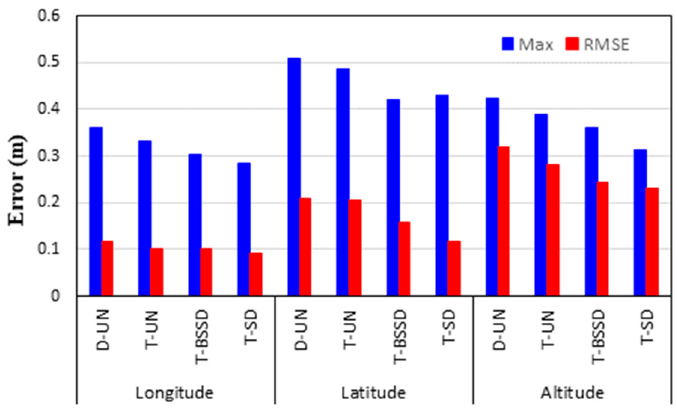
Figure 9. Maximum and RMSE values of the positioning errors for different kinematic PPP Figure 9. Field measurement setup for base ( left ) and rover ( right ) stations. solutions.